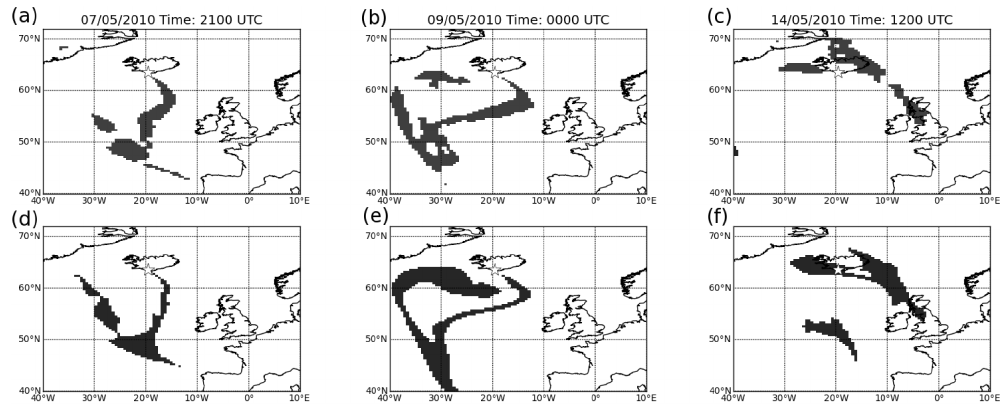
Figure 2. (a) – (c) Satellite-detected ash clouds, (d) – (f) NAME simulated ash clouds after pixel matching. (a) , (d) 21:00UTC 7 May 2010. (b) , (e) 00:00UTC 9 May 2010. (c) , (f) 12:00UTC 14:00 May